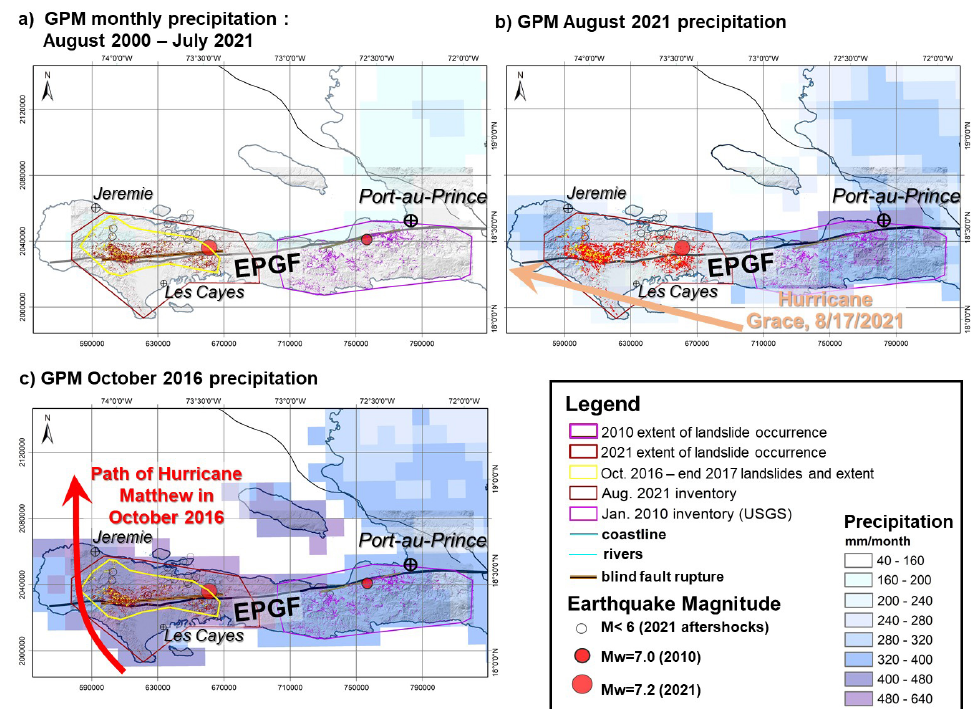
Figure A4. Monthly © Global Precipitation Measurement Mission (NASA) maps (0.1 ◦ resolution, values in mm per month) for southwestern Haiti, (a) for all months between August 2000 and July 2021, (b) for August 2021 (marked by the Hurricane Grace event), and (c) for October 2016 (marked by the Hurricane Matthew